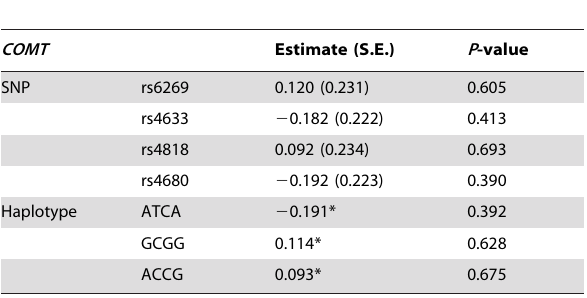
Table 5. Maternal COMT analysis for body mass index.